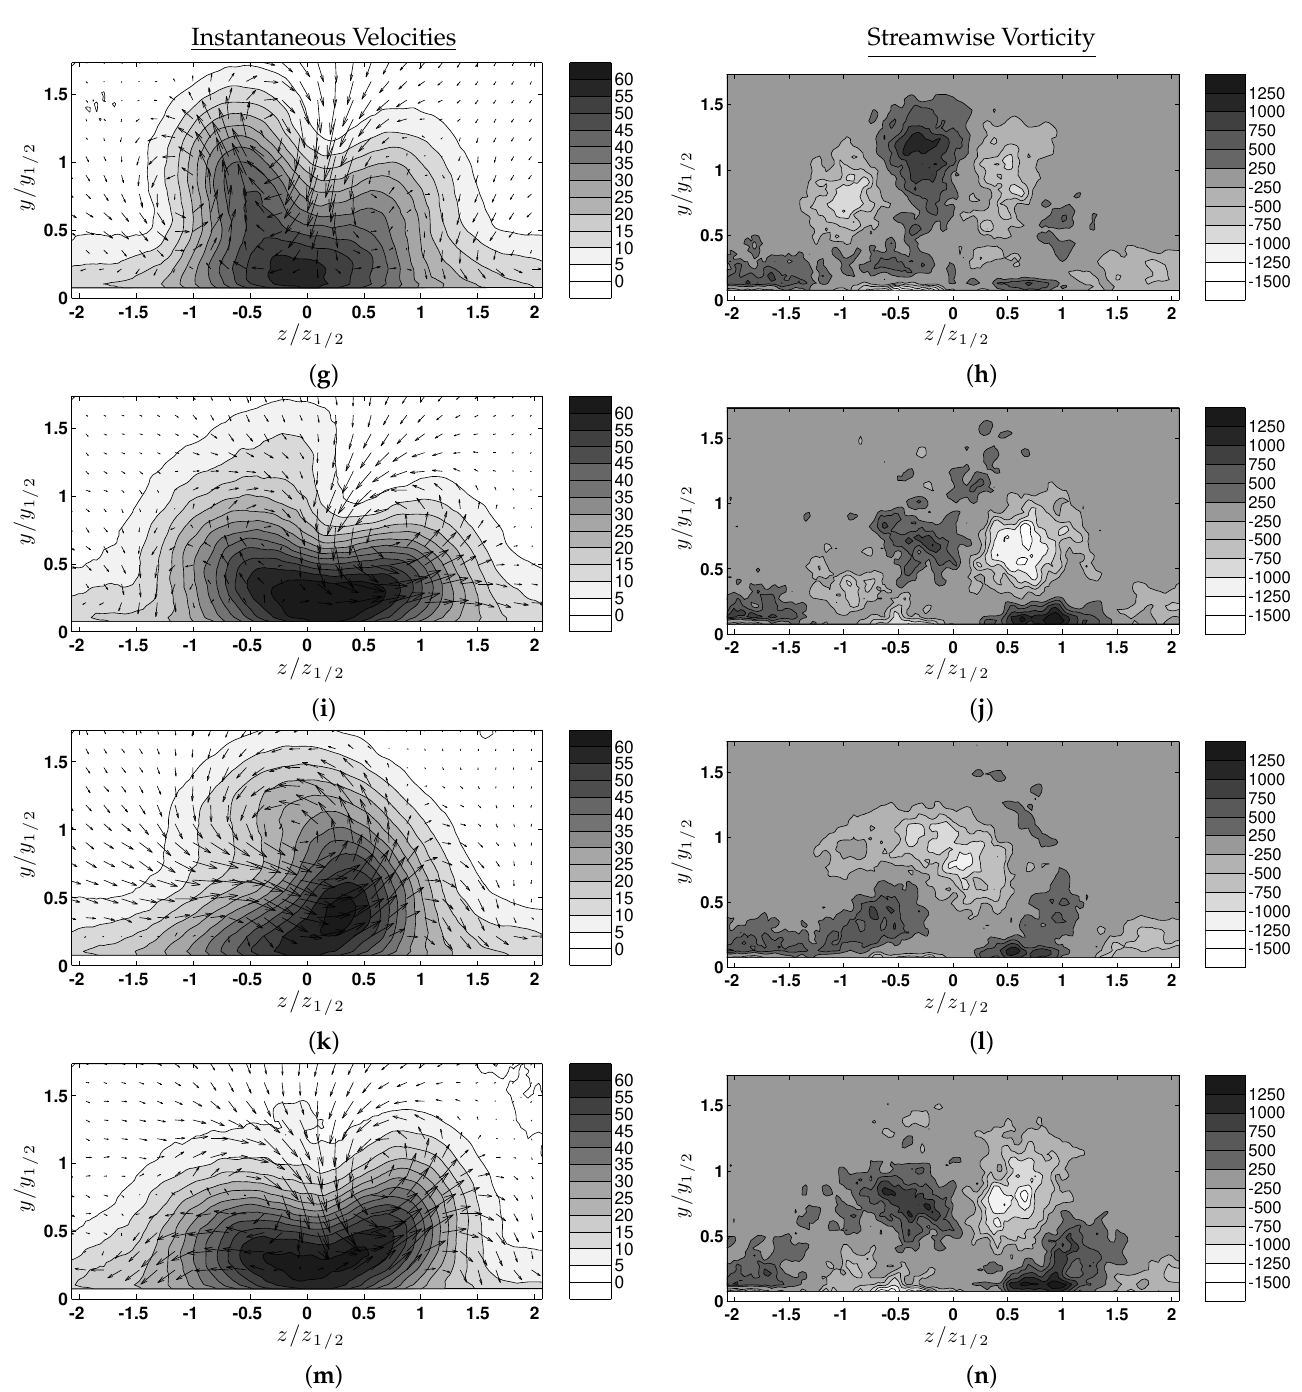
Figure 7. POD reconstruction of the instantaneous velocity ( m / s ) using the first 10 modes and the reconstructed instanta- neous streamwise vorticity ( 1/ s ) at x / D = 15. The mean streamwise velocity (normalized) and mean streamwise vorticity are shown in the first